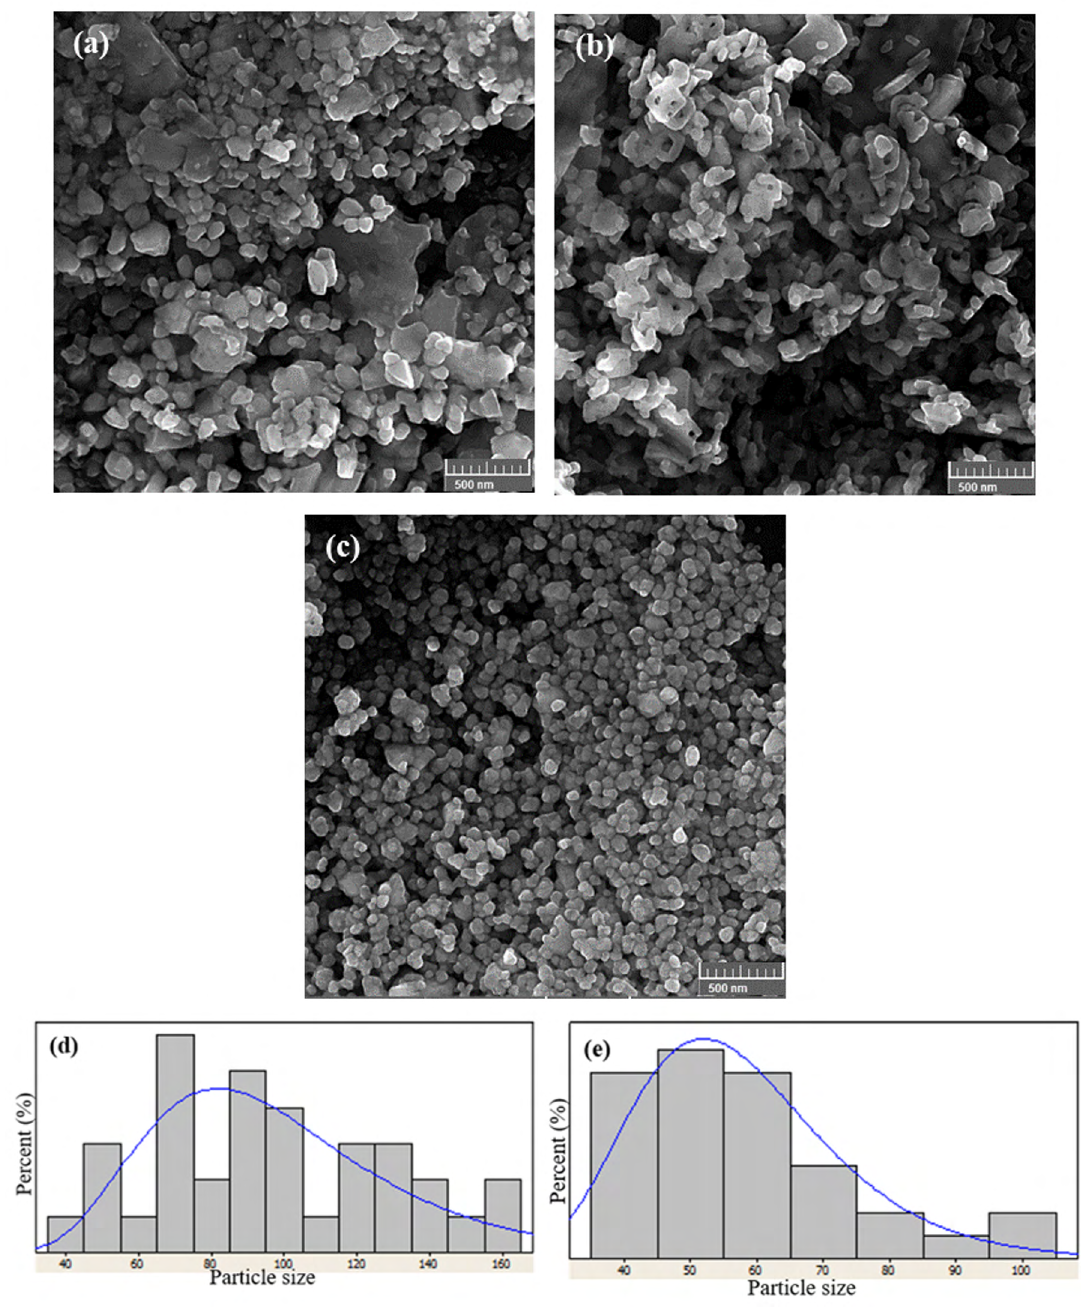
Figure 3. FESEM images of the powders prepared using different amounts of oxalic acid and PEG; (a) 131 and 16.5 (sample C1); (b) 196 and 4 (sample C2), and (c) 262 and 8.25 mmol (sample C3), respectively; (d) and (e) particle size distribution for Figure 3(a) and Figure 3(c), respectively